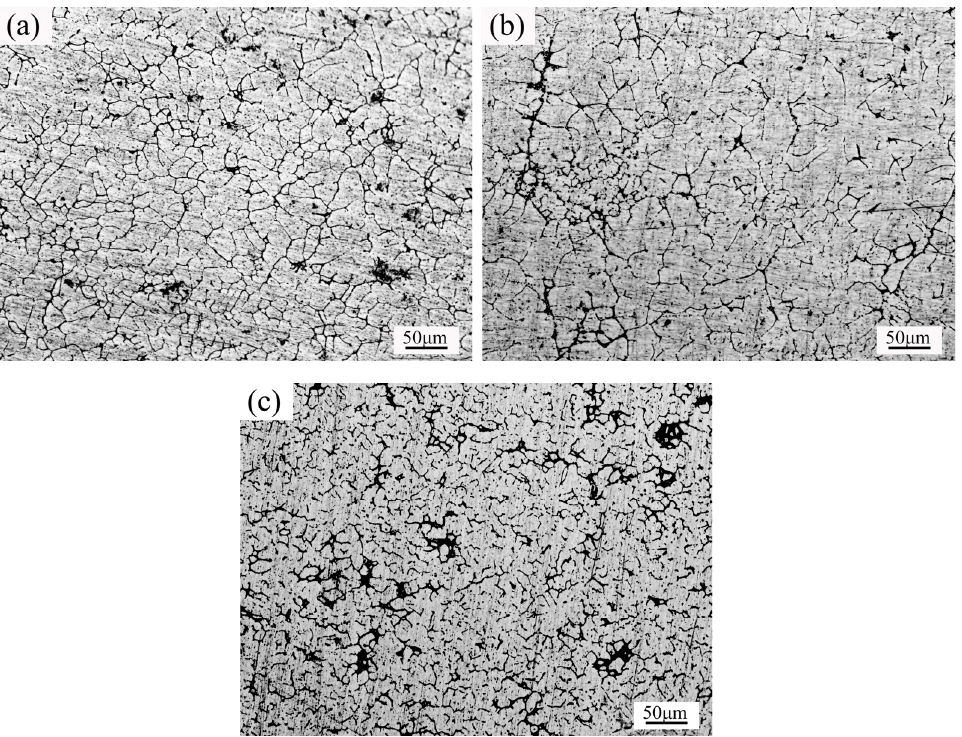
Figure 13. Metallographic photographs of the samples at different position of forming parts: ( a ) flange; ( b ) side wall; ( c ) bottom.